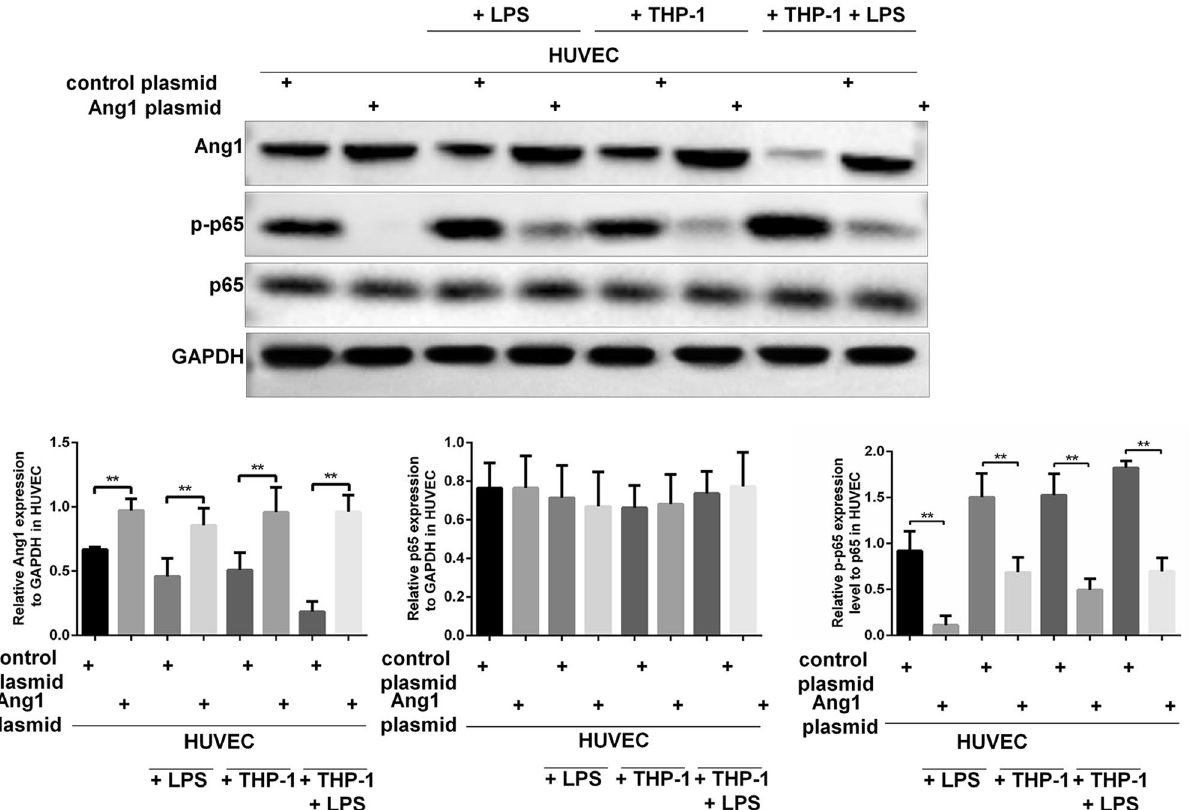
Figure 4. Ectopic expression of Ang1 remarkably reduced the phosphorylation of p65 in HUVECs under various conditions. HUVECs were transfected with Ang1-expressing plasmid or control plasmid for 24 h; and then the HUVECs were cultured alone with/without LPS (100 μg/mL) for 8 h, or co-cultured with THP-1- derived macrophages with/without LPS (100 μg/mL) for 8 h. Protein expressions of Ang1, p65 and p-p65 in the HUVECs were measured by western blot. Relative expressions of Ang1 and p65 (normalized to GAPDH), and the ratio of p-p65 to p65 were quantified. n = 3 for each group. Data are expressed as mean ±